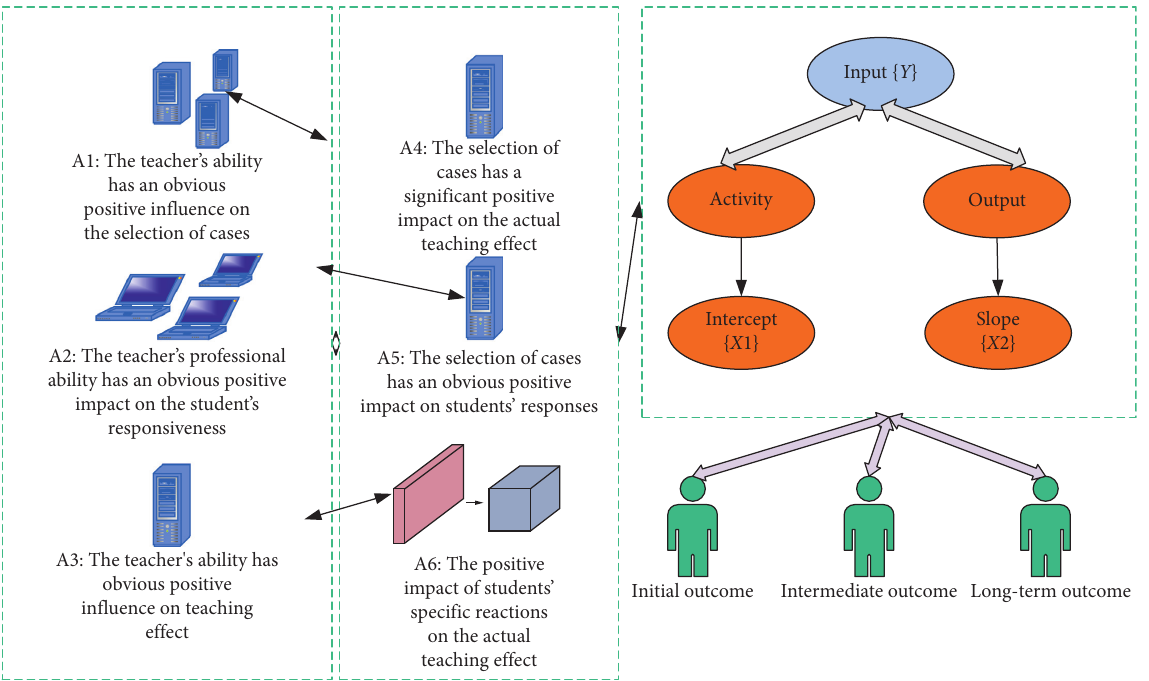
Figure 2: Structural equation model.